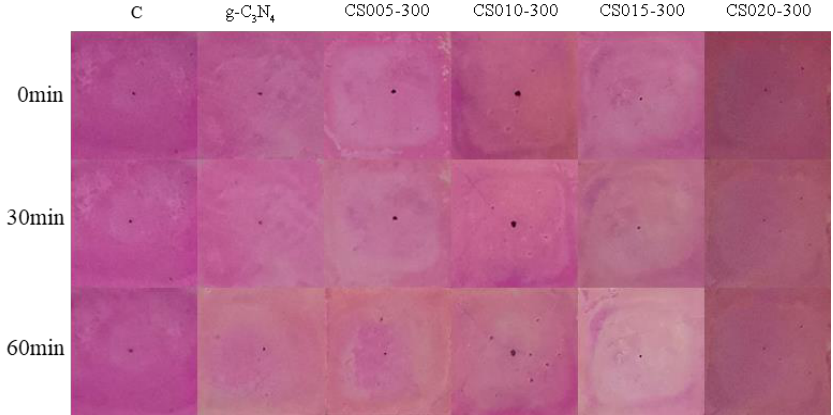
Figure 11. Photocatalytic performance of surface treatment cement with the one-sided immersion method.